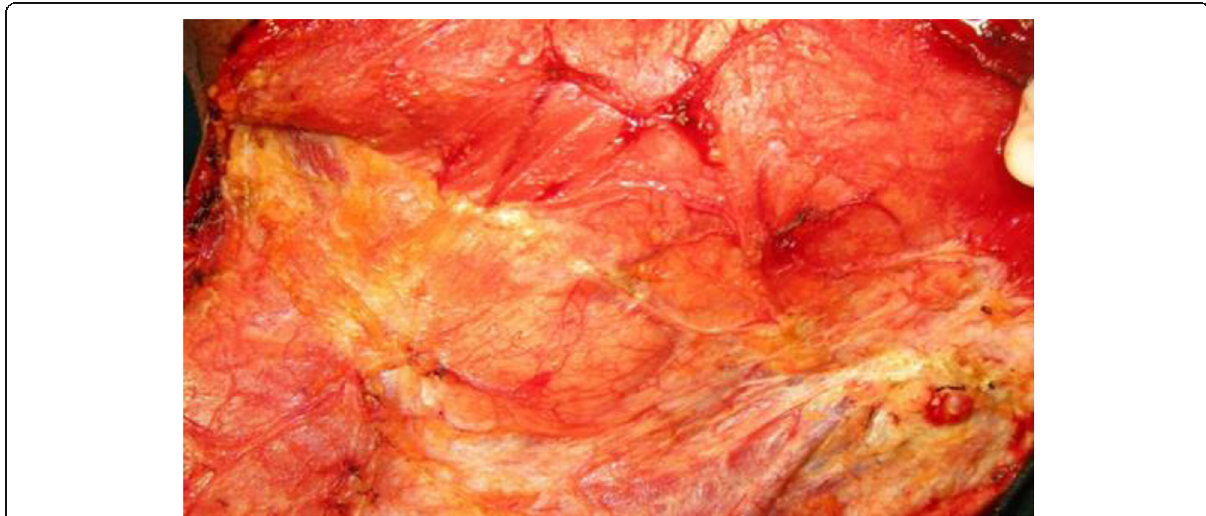
Fig. 21 Nerve traveling below lower border of mandible within the deep fascia